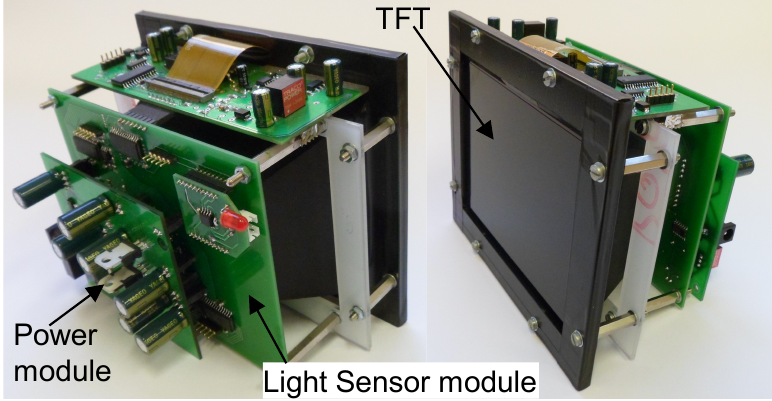
Figure 11. The prototype of the indoor positioning sensor.